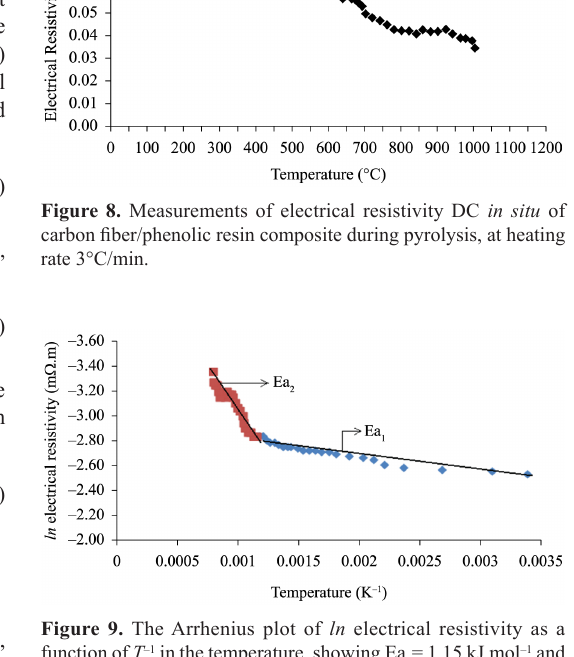
= 1.15 kJ.mol –1 and 1